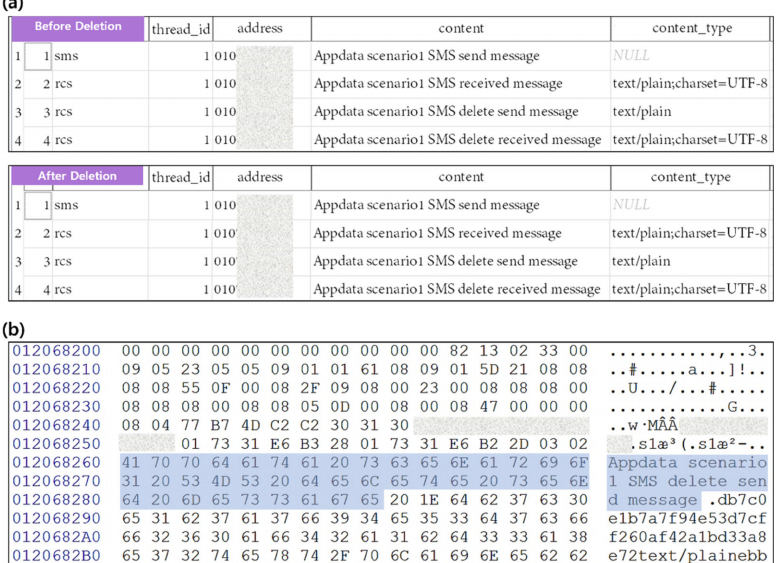
Figure 3. Analysis of db file and db-wal file before and after Message data deletion using scenario I ( a ) Comparison of mmssms.db before and after app data deletion ( b ) Traces of deleted data remaining in mmssms.db. The blue box indicates data remaining after